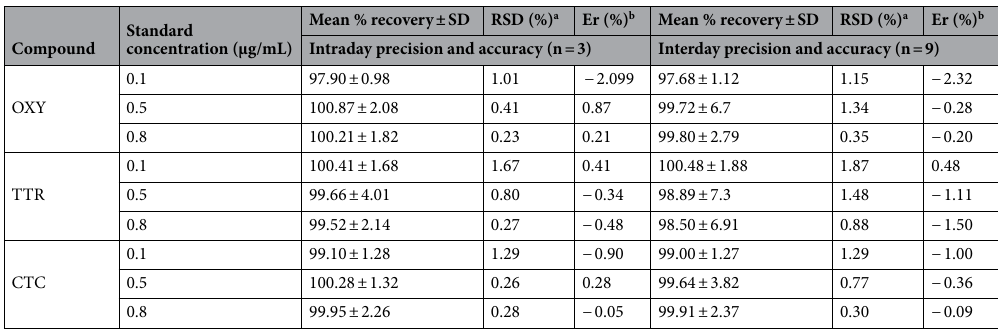
Table 3. Intraday and interday precision and accuracy for the tetracycline drugs. a RSD (%) Percentage relative standard deviation. b Er (%) Percentage relative error.